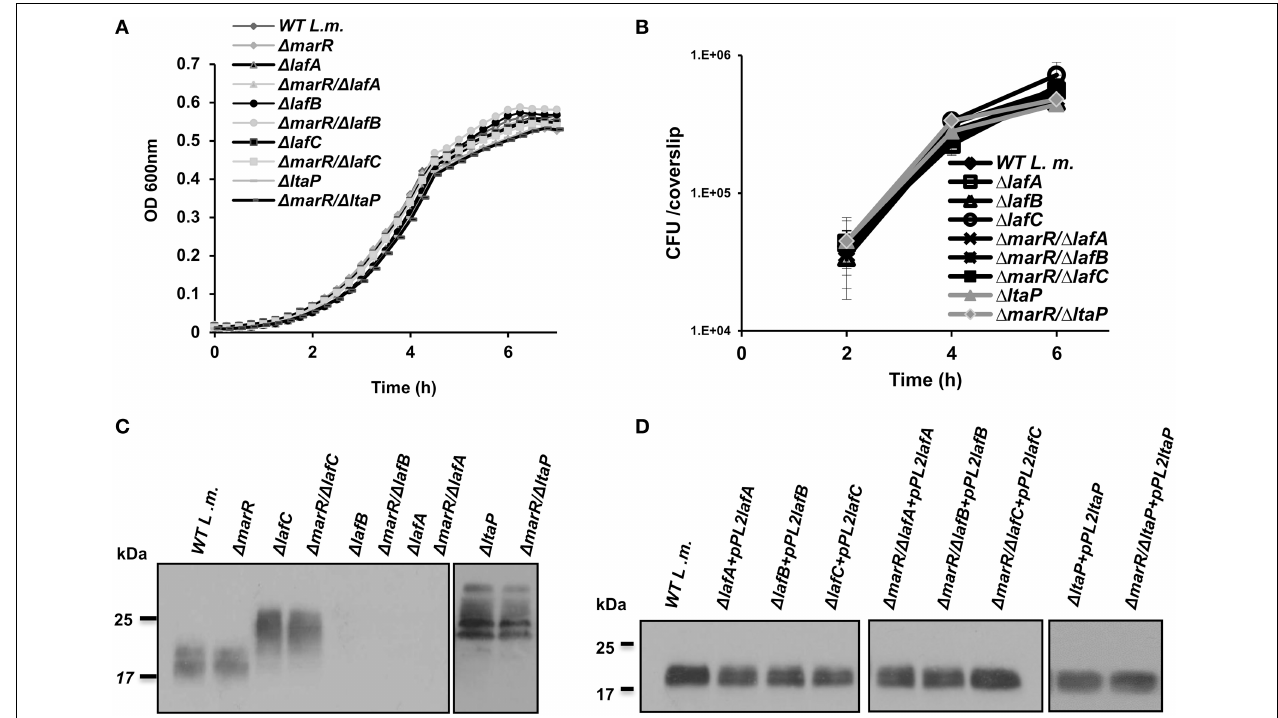
FIGURE 2 | LTA is dispensable for L. monocytogenes growth in rich laboratory medium and intracellularly in macrophage cells. (A) Growth curves of WT L. monocytogenes , (cid:2) marR and in-frame deletion mutants of lafA , lafB , lafC, and ltaP genes in the background of WT and (cid:2) marR bacteria in BHI medium at 37 ◦ C. Experiment was performed in a 96-well format in a Synergy HT Biotek® plate reader. Error bars representing standard deviation of a triplicate are hidden by the symbols. The data is a mean of three biological repeats ( N = 3). (B) Intracellular growth curves of WT L. monocytogenes , (cid:2) marR and in-frame deletion mutants of lafA , lafB , lafC, and ltaP gens in the background of WT and (cid:2) marR bacteria in BMD